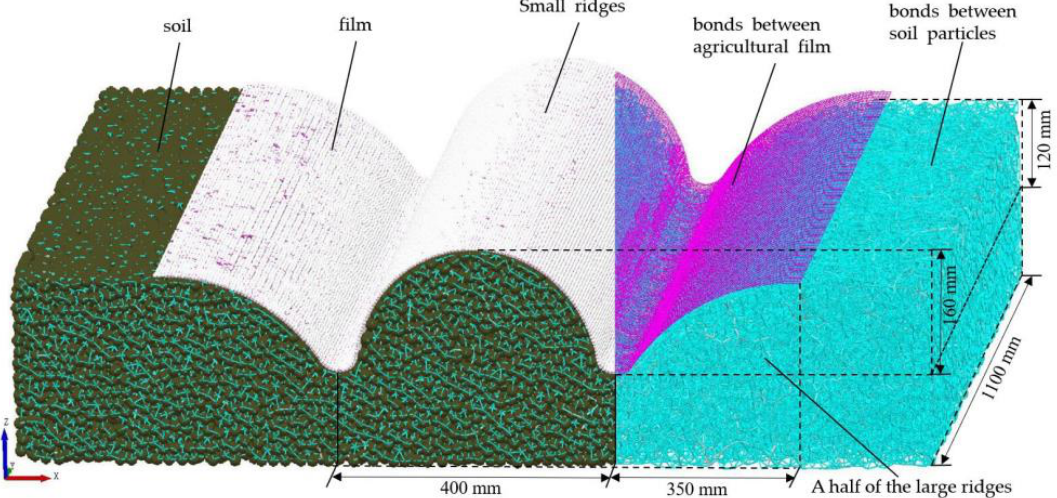
Figure 2. Discrete element model of whole plastic-film mulching on double ridges.